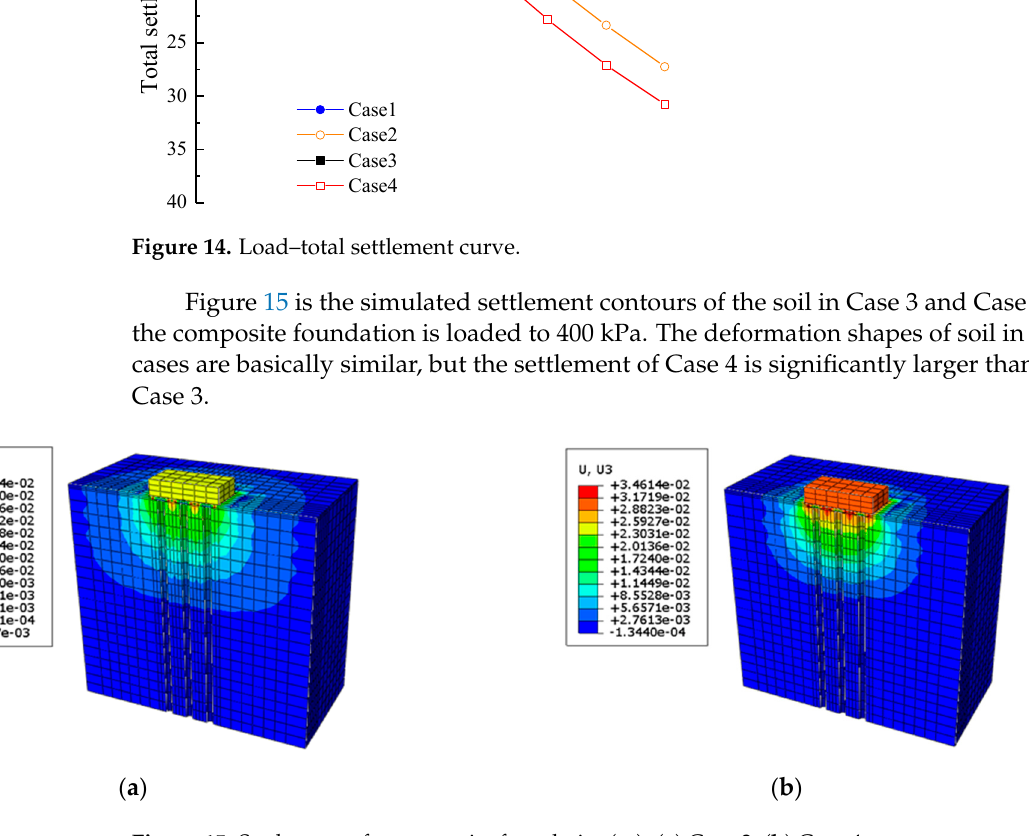
Figure 16. Curve of load–soil pressure.